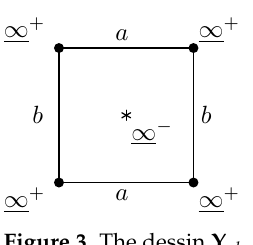
Figure 3. The dessin Y abab